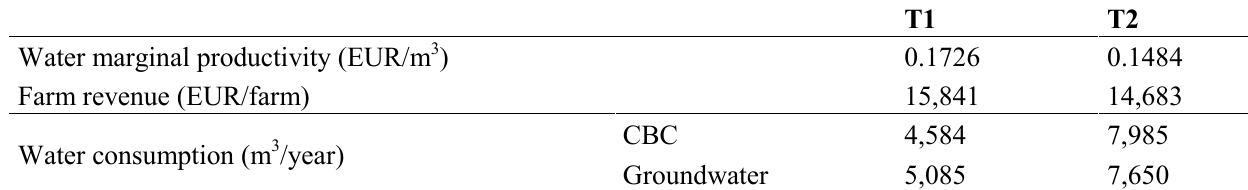
Table 4. Overview of farm performances, under the status-quo